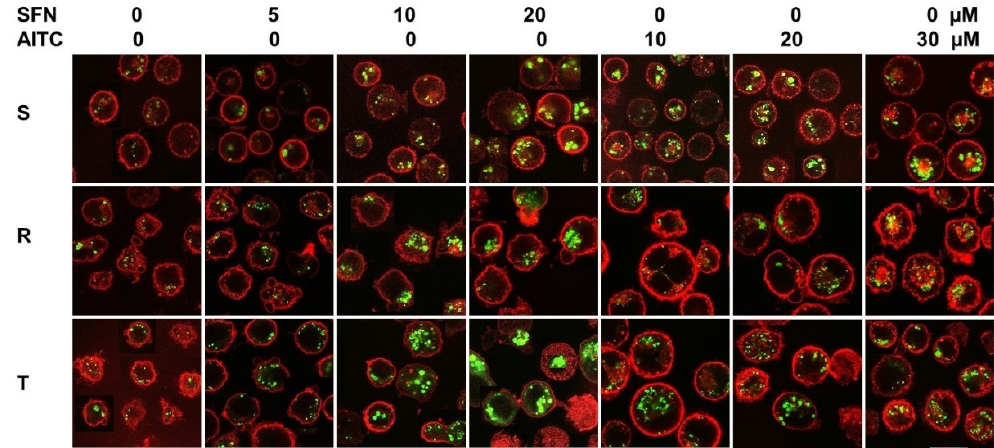
Figure 8. Visualization of autophagic vesicles in S, R and T cells using MDC. Cells were stained by MDC in the presence of 500 nM TQR. Cells after 24 h of incubation in medium containing SFN and AITC at the given concentrations were used in the experiment. Data are representative of three independent experiments.